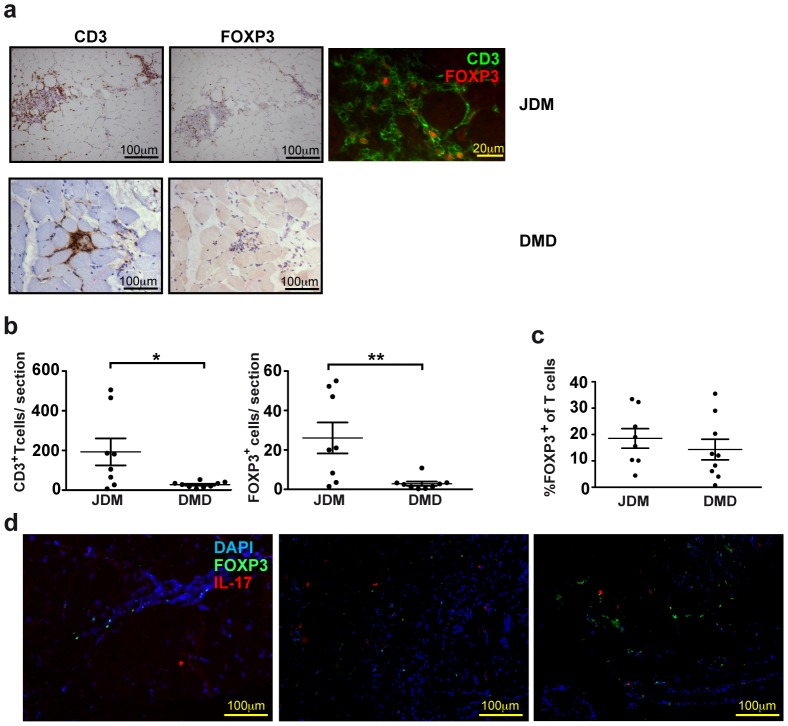
FOXP3+ T cells are present in inflamed muscle of newly diagnosed, untreated patients with active JDM.(A) Representative pictures of both immunohistochemistry single stainings for CD3, a marker for T cells (left), FOXP3 (middle) on consecutive sections from muscle biopsies (all at 20× magnification, brown-red indicates positive staining), which were used to analyze cell numbers. The right panel shows an example of immunofluorescence staining (1 out of 4) of a tissue section of a JDM patient, showing FOXP3 (red) expressed in the nuclei of CD3+ T cells (green). The upper row shows sections of JDM muscle, the second row shows DMD muscle sections. (B) Average numbers of infiltrated CD3+ cells and FOXP3+ cells, and (C) percentages of CD3+ T cells expressing FOXP3 per section of 8 JDM patients and 9 DMD patients, calculated for each patient, by counting cells from the immunohistochemistry single stainings on consecutive sections, as described in the methods section. Mean ± SEM cell counts: (JDM) CD3 192.7±67.9, FOXP3 26.1±4.8, (DMD) CD3 27.7± 4.8, FOXP3 2.9±1.1, D) Paraffin embedded muscle sections of patients with active JDM were stained with anti-IL-17 (red), FOXP3 (green) and DAPI (blue). Three representative pictures (20× magnification) are shown (N = 3 active JDM patients, at the time of diagnosis, without medication). All graphs show mean percentages ± SEM. *P<0.05, **P<0.01, Mann Whitney U test was used.